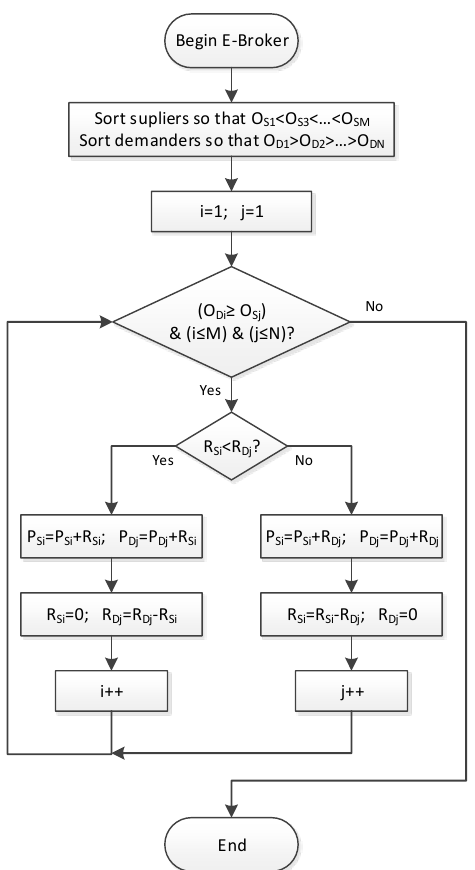
Figure 4. E-Broker Auction Algorithm flow chart.